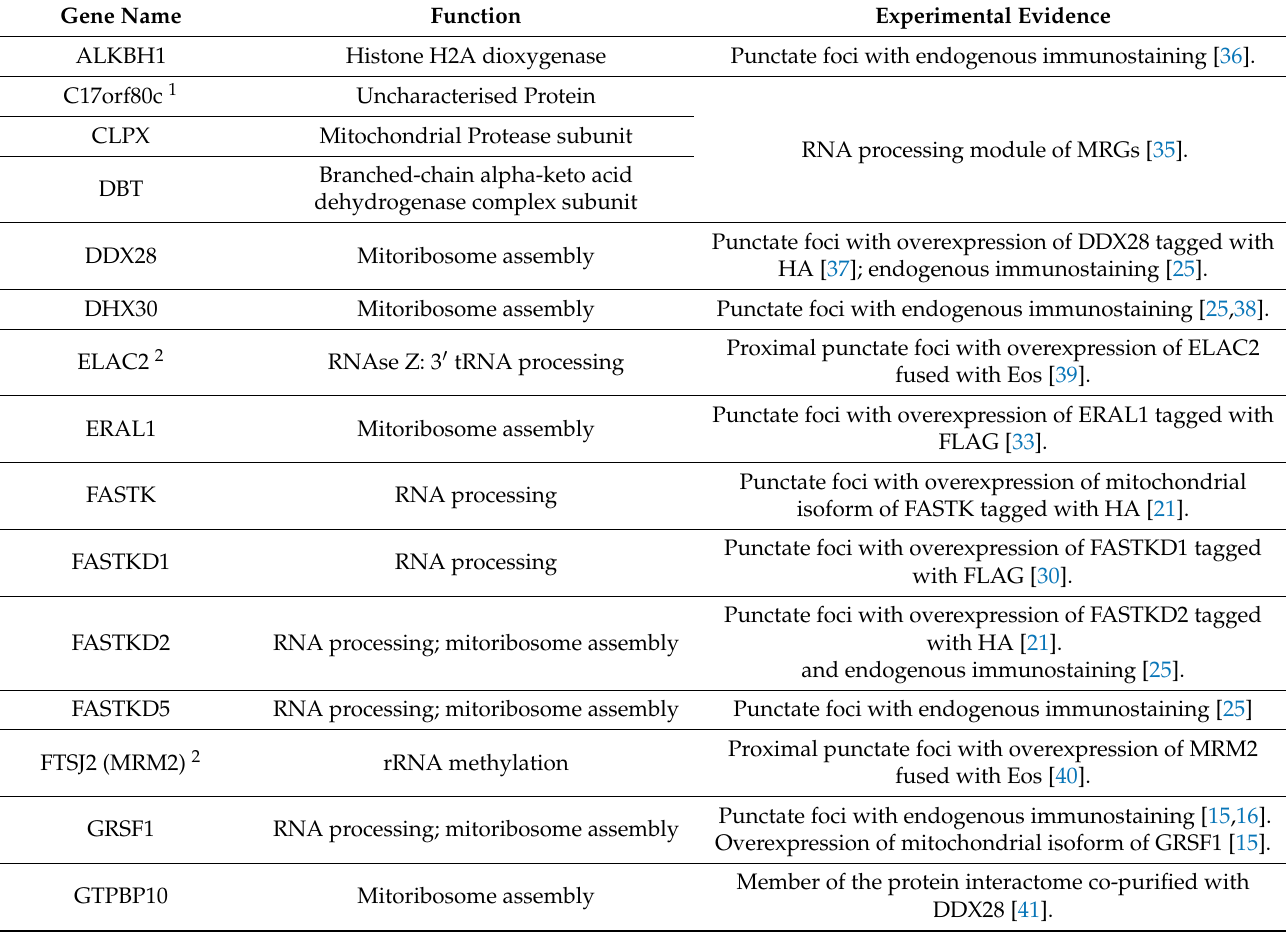
Table 1. The proteome of MRGs is tabulated below detailing their coding gene, mitochondrial function and the published experimental evidence for their localisation in